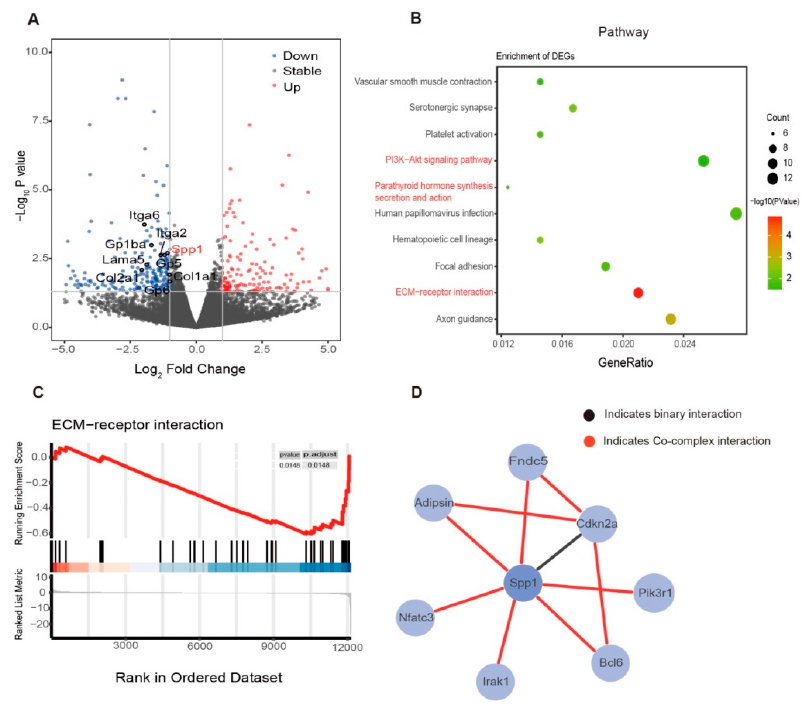
Figure 2. RNA-Seq of bone marrow indicated that exercise inhibited Spp1 and related ECM-receptor pathways. Representative bone marrow from tibia of both the obesity and exercise groups ( N = 2,2) were isolated for RNA-Seq analysis. ( A ) volcano plot of bone marrow in the exercise group compared to the obesity group. Colored dots represent p value < 0.05 ( − log 10 ( p Value) > 1.3, gray line), log 2 Fold Change > 1 up-regulated genes (red), and log 2 Fold Change < − 1 down-regulated genes (blue). Selected ECM-receptor pathway related genes are highlighted. ( B ) results of pathway enrichment analysis for highly variable genes identified by significant DEG in the bone marrow. ( C ) gene set enrichment analysis of ECM-receptor interaction. ( D ) protein interaction network diagram of Spp1. The original data come from the HINT (http://hint.yulab.org, accessed on 31 May 2022) database, a database of high-quality protein–protein interactomes. ECM, extracellular matrix.